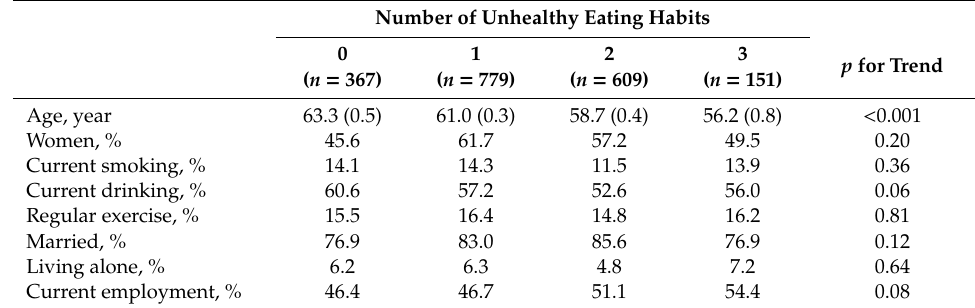
Table 3. Age- and sex-adjusted characteristics of the study participants according to the number of accumulated unhealthy eating